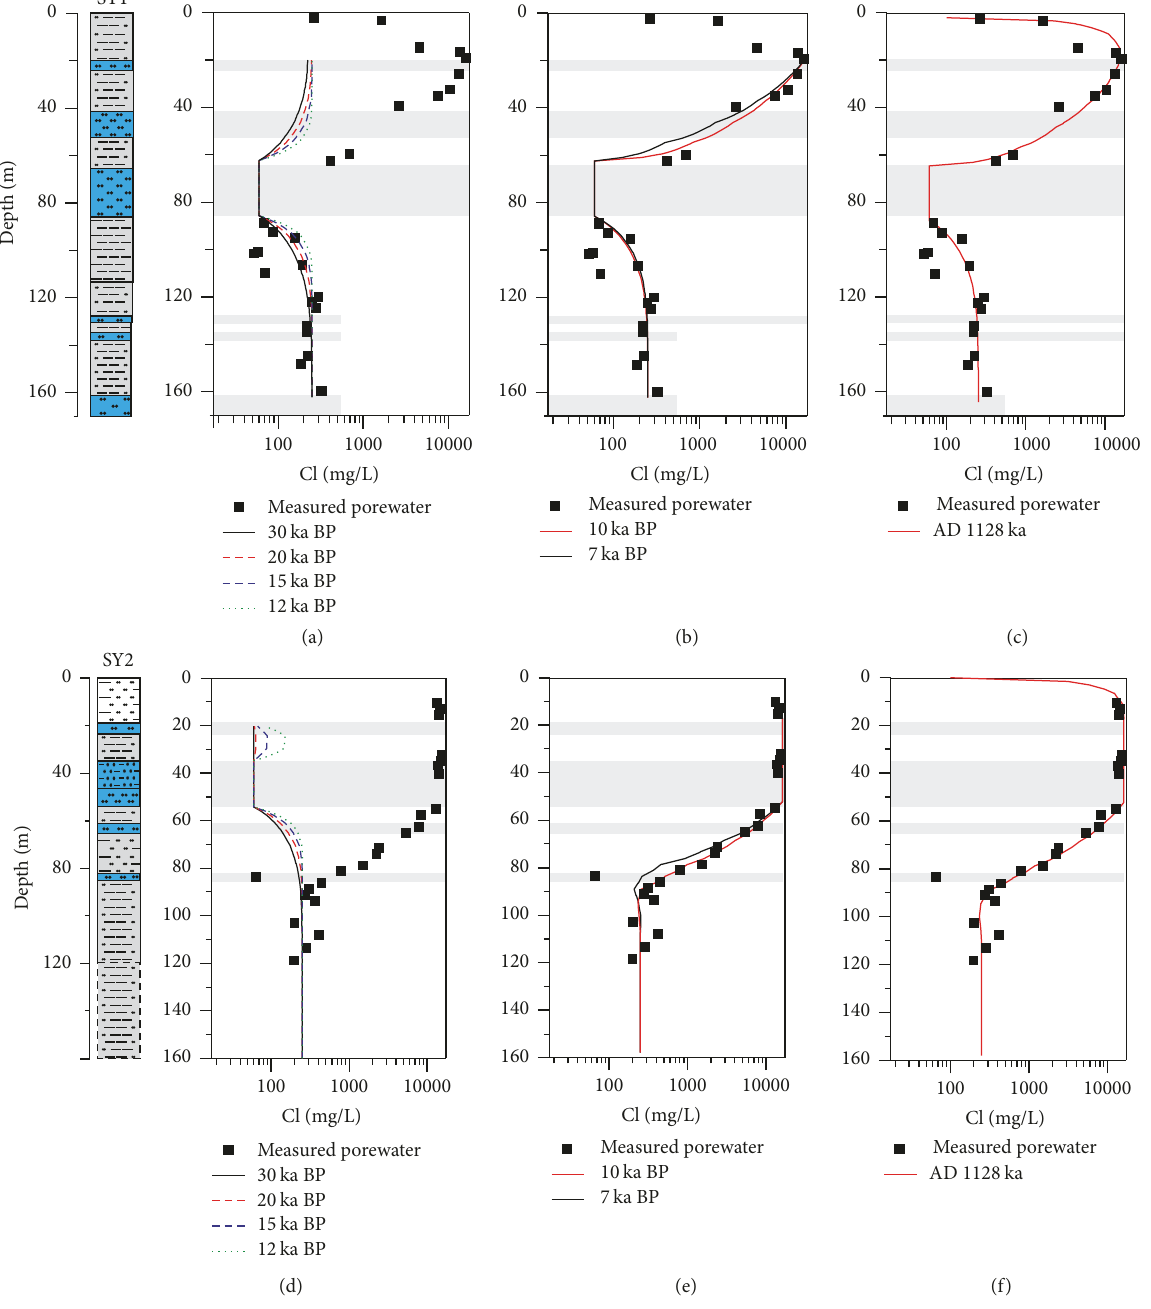
Figure 8: Measured and modeled Cl − concentration profiles in aquitard-aquifer system at the studied boreholes. (a, d) SY1 and SY2 profiles between 30 and 12ka BP with a fresher boundary condition of the Aquifer I. (b, e) Using the simulation result of 15 ka BP as the new initial condition, simulated borehole profiles after a further 10ka BP and 7ka BP with a saline upper BC. (c, f) Using the simulation result of 10 ka BP as the new initial condition, simulated SY1 profiles after a further AD 1,128 with a fresher upper BC. The black dotted bordered rectangles in the borehole SY2 profile represent the sediments that were not revealed in the borehole